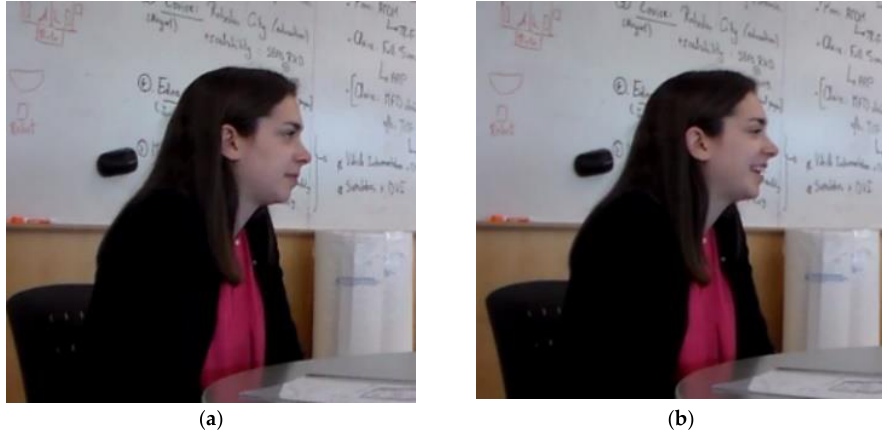
Figure 6. Comparison between ( a ) a participant’s neutral expression and ( b ) a positive facial expression.